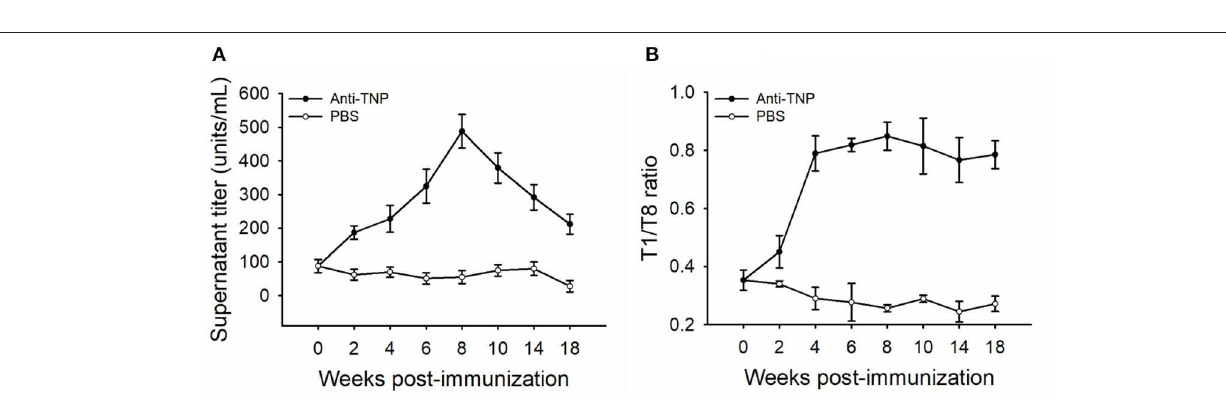
FIGURE 5 | Kinetics of TNP-specific antibody titers and affinities secreted by LLPCs. The sample of detection was from the supernatant of HU-resistant plasma cells cultured in vitro for 15 days. The antibody titer (A) and affinity (B) shown are the average of five fish ( n = 5). The PBS-immunized group was used as the control. Error bars represent standard deviation of the